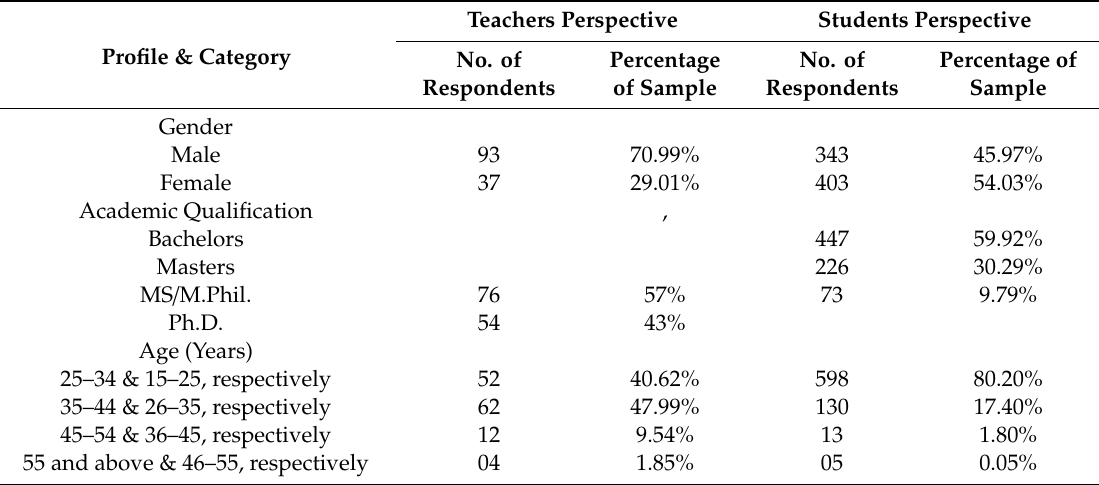
Table 1. Demographic information of the